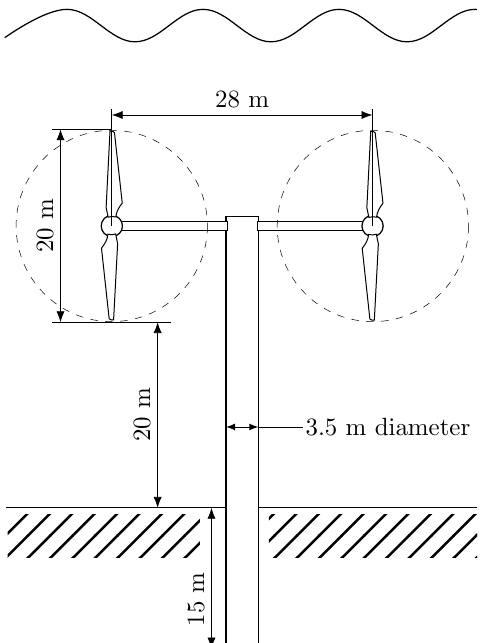
Figure 11. RM1 device schematic (adapted from [22], Figure 3-2 with